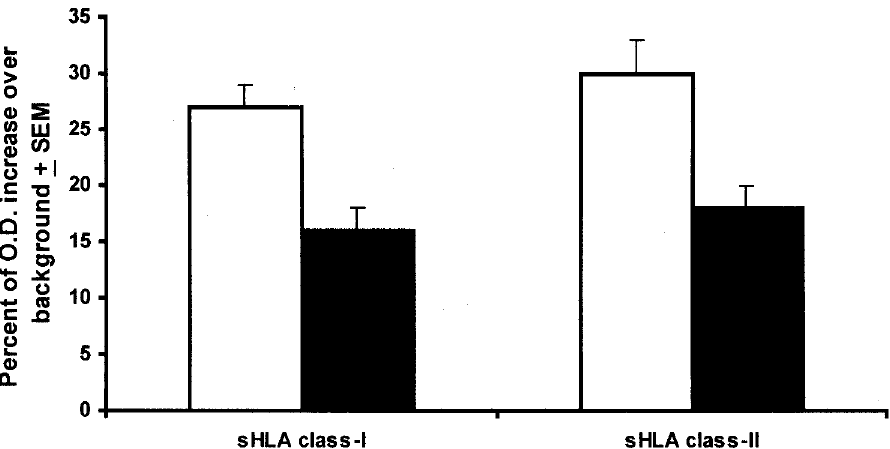
FIG. 1. Serum-soluble human leukocyte antigen (sHLA) class-I and class-II levels in healthy subjects (controls, white bars) and in women with endometriosis (black bars). Soluble class I was detected by the monoclonal antibody 83H1 (HLA-A,B,C, IgG1), 19,20 and class II by the monoclonal antibody 7H3 (HLA-DR, IgG2a). 20 The decrease of soluble antigens for both HLA classes is of the significance order of P < 0.001. The results are expressed as percent of optical density (OD) increase over background levels (±SEM). Background levels (OD values of coating buffer) corresponded to 0.110 ± 0.015 and 0.075 ± 0.008 for the class-I and class-II antibodies, respectively. The experiment was repeated three times and similar results were